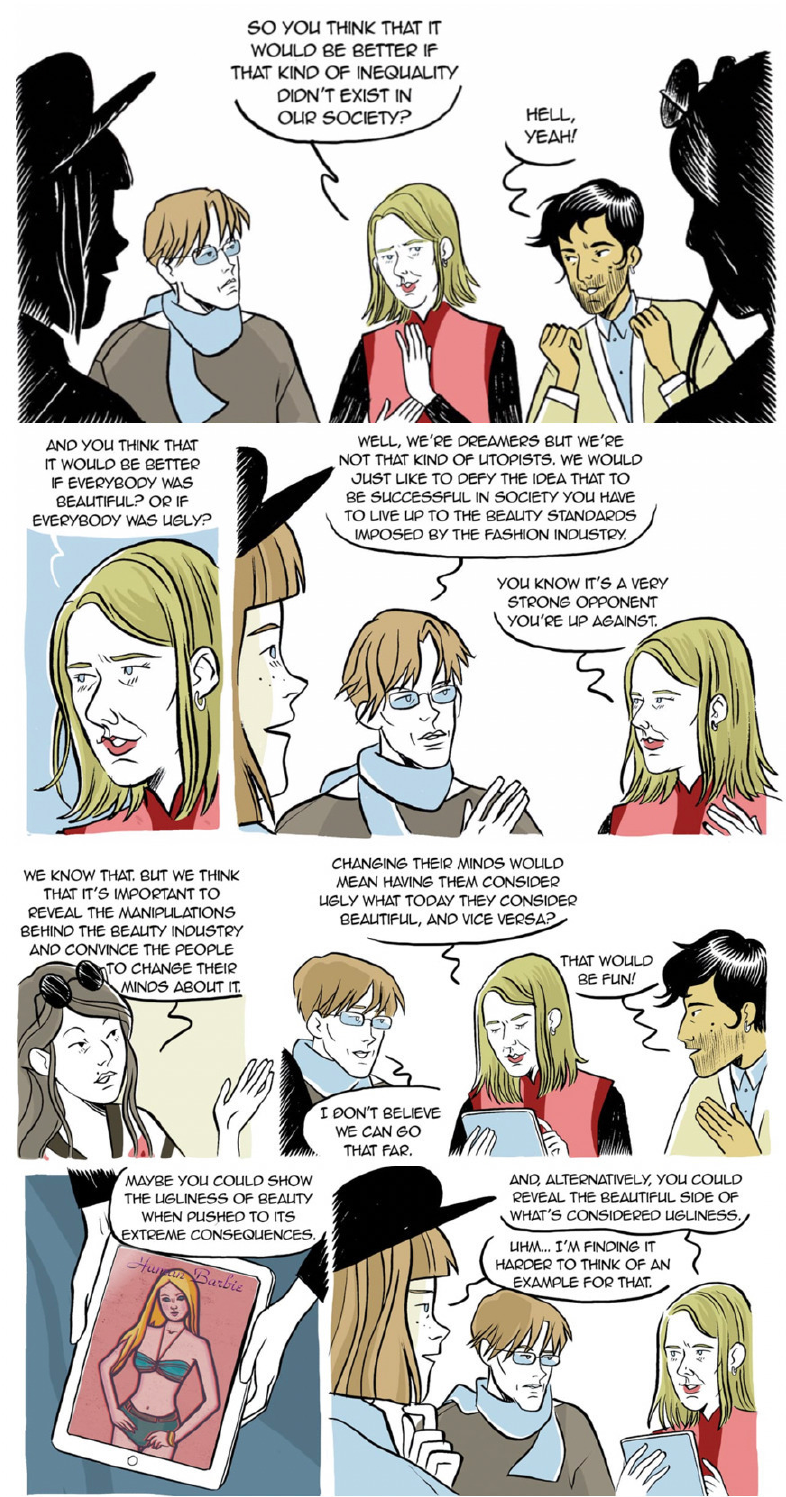
Figure 4: A Sociological